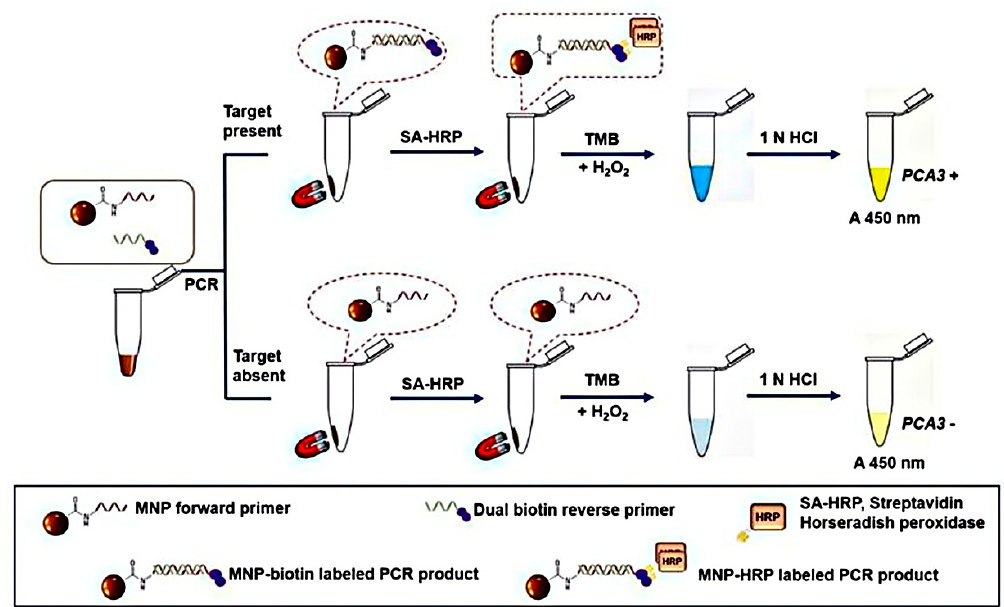
Figure 6. A graphical representation of the MNP-combined oligonucleotide for PCA3 detection in urinary sediments. Reproduced from [94] with permission from Leibniz Research Centre for Working Environment and Human Factors, 2020.